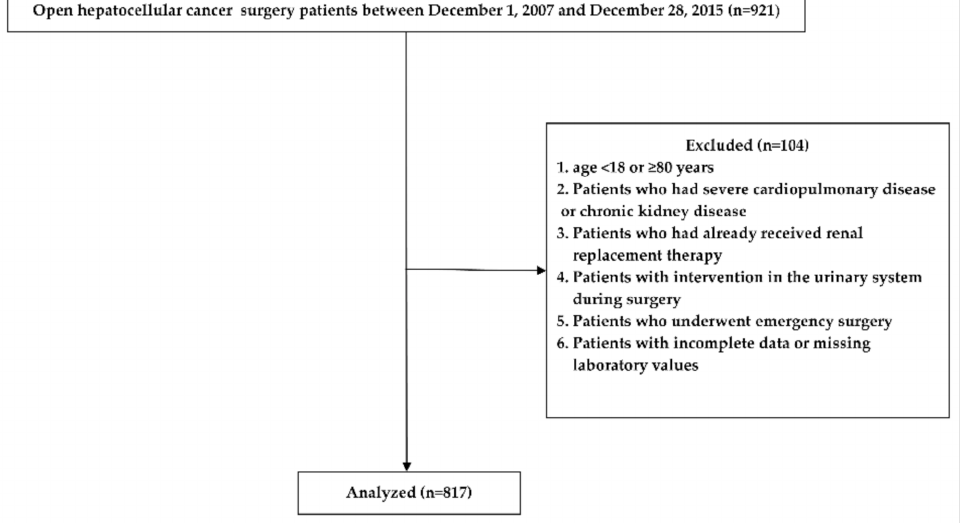
Figure 1. Study flow chart.